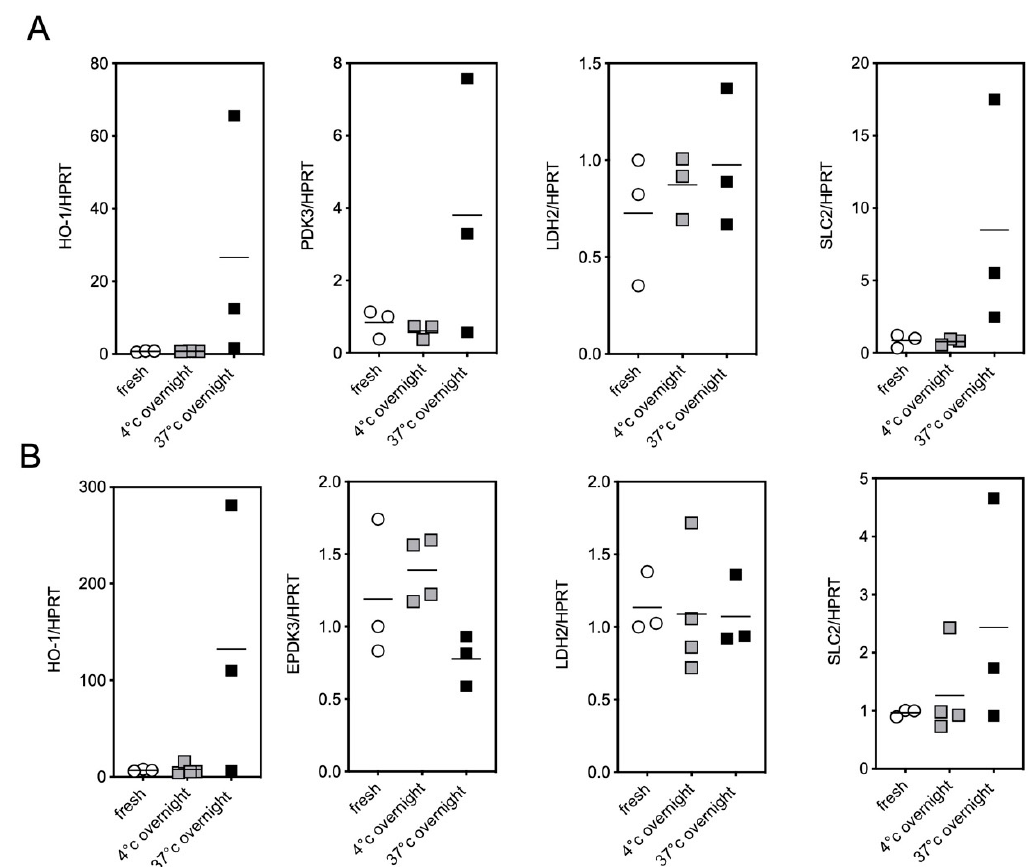
Figure A5. Effect of overnight conservation of heart and lung samples on hypoxia and mitochondrial ultrastructure. Heart and lung samples, either fresh or conserved overnight at 4 °C or 37 °C, were compared. ( A and B ) heme oxygenase 1 (HO-1), pyruvate dehydrogenase 3 (PDK3), Lactate dehydrogenase A (LDH2), GLUT3 Transporter (SLC2A3) mRNA level normalized on Hypoxanthine guanine phosphoribosyltransferase (HPRT) quantified by RT-qPCR analysis in heart ( A ) or in lung ( B